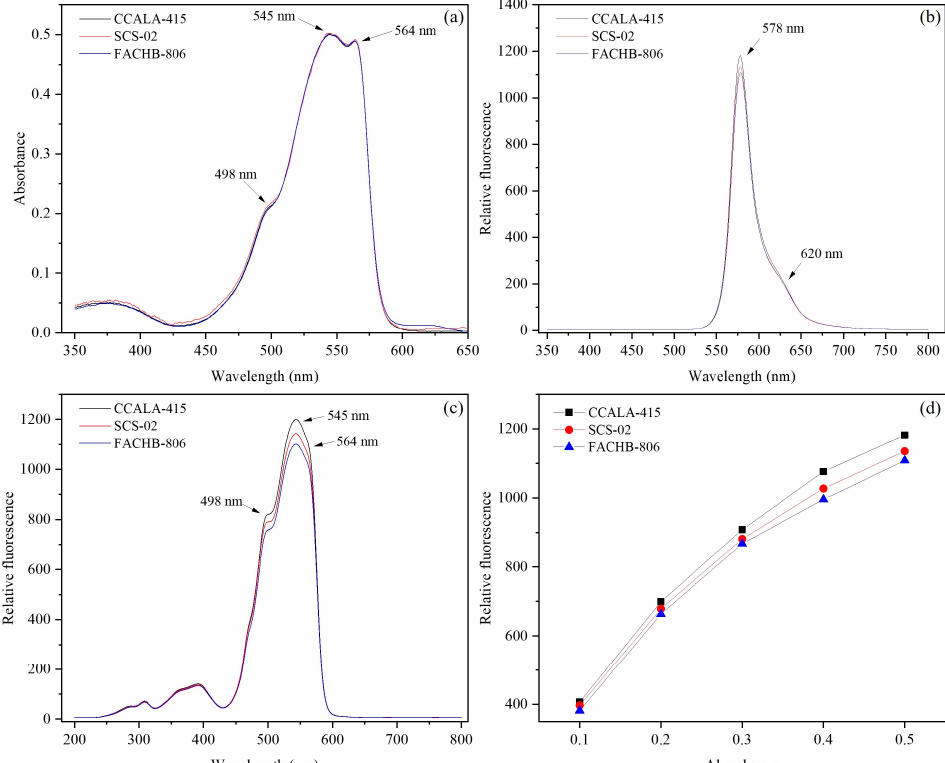
Figure 5. The fluorescence characteristics of phycoerythrin from Porphyridium cruentum CCALA-415, Porphyridium purpureum SCS-02 and Porphyridium purpureum FACHB-806. ( a ) The absorption spectra of the purified phycoerythrin at room temperature; ( b ) The fluorescence emission spectra of the purified phycoerythrin (the excitation wavelength at 545 nm); ( c ) The fluorescence excitation spectra of the purified phycoerythrin (the emission wavelength at 578 nm); ( d ) The relative fluorescence intensity at the emission wavelength of 578 nm (the excitation wavelength at 545 nm) under the OD 545 of the purified phycoerythrin at 0.1, 0.2, 0.3, 0.4 and 0.5, respectively. OD 545 represents the optical density at 545 nm. The values shown are the averages of three technical replicates ± standard deviation.